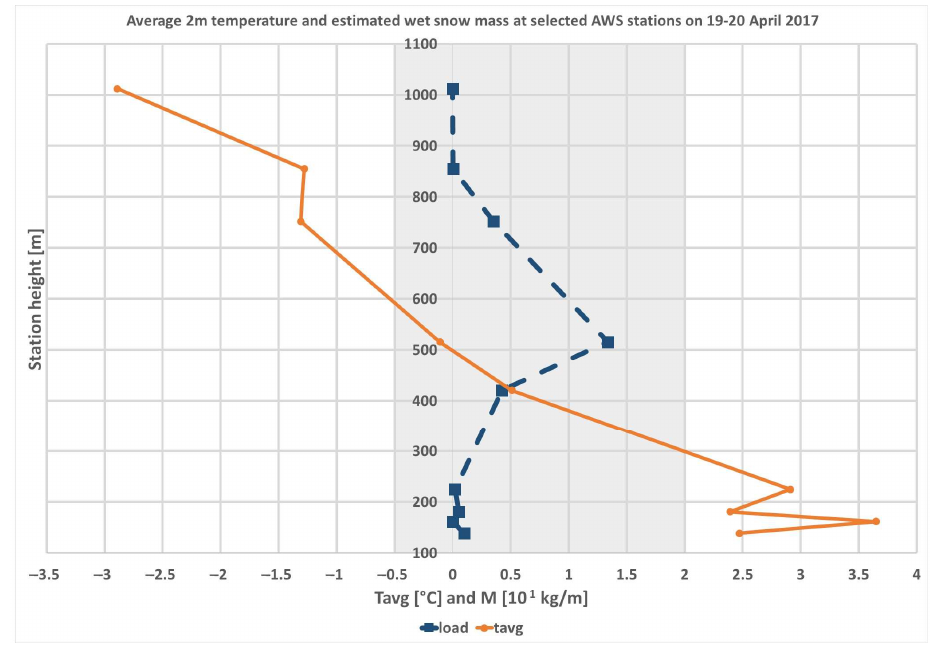
Figure 14. Variation of 2 m average temperature (solid line, °C) and estimated wet snow mass (dashed line, 10 1 kg·m −1 ) with station height (m) during the case of 19–20 April 2017. The profiles were constructed from measurements of synoptic and AWS stations. Averaging of temperature was applied for the period of precipitation at each station. The shaded rectangle emphasizes the range of temperature, where wet snow was considered (−0.5, 2 °C).